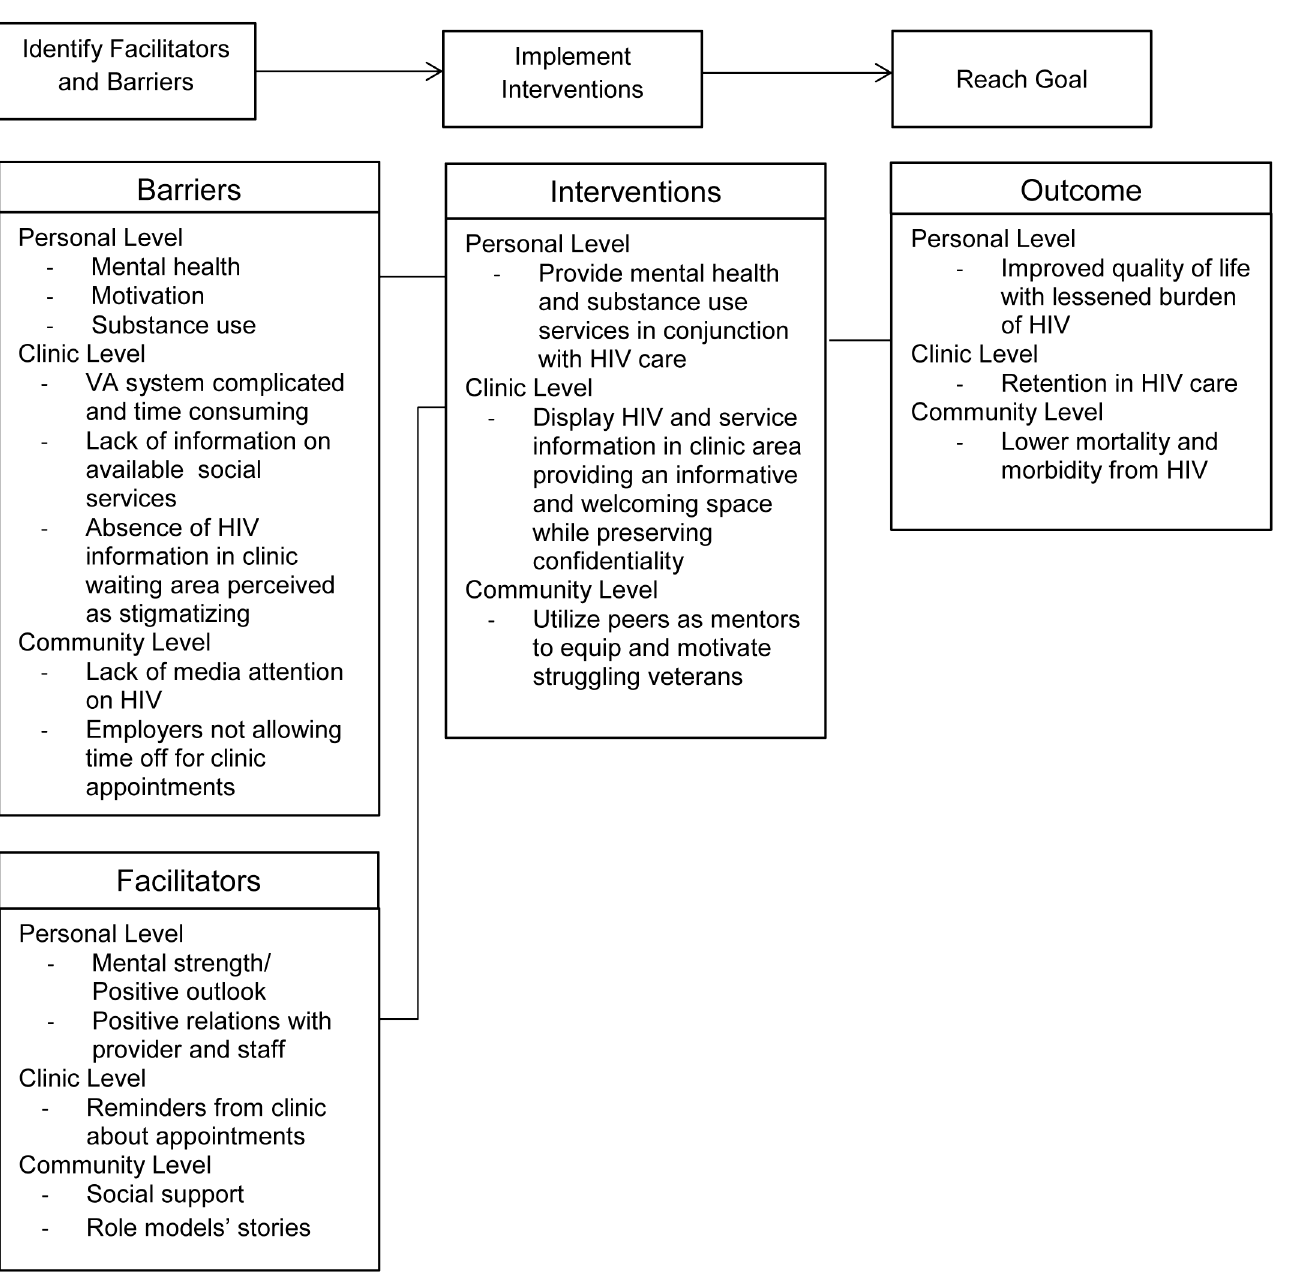
Fig 2. Intervention map to achieve routine care for veterans with